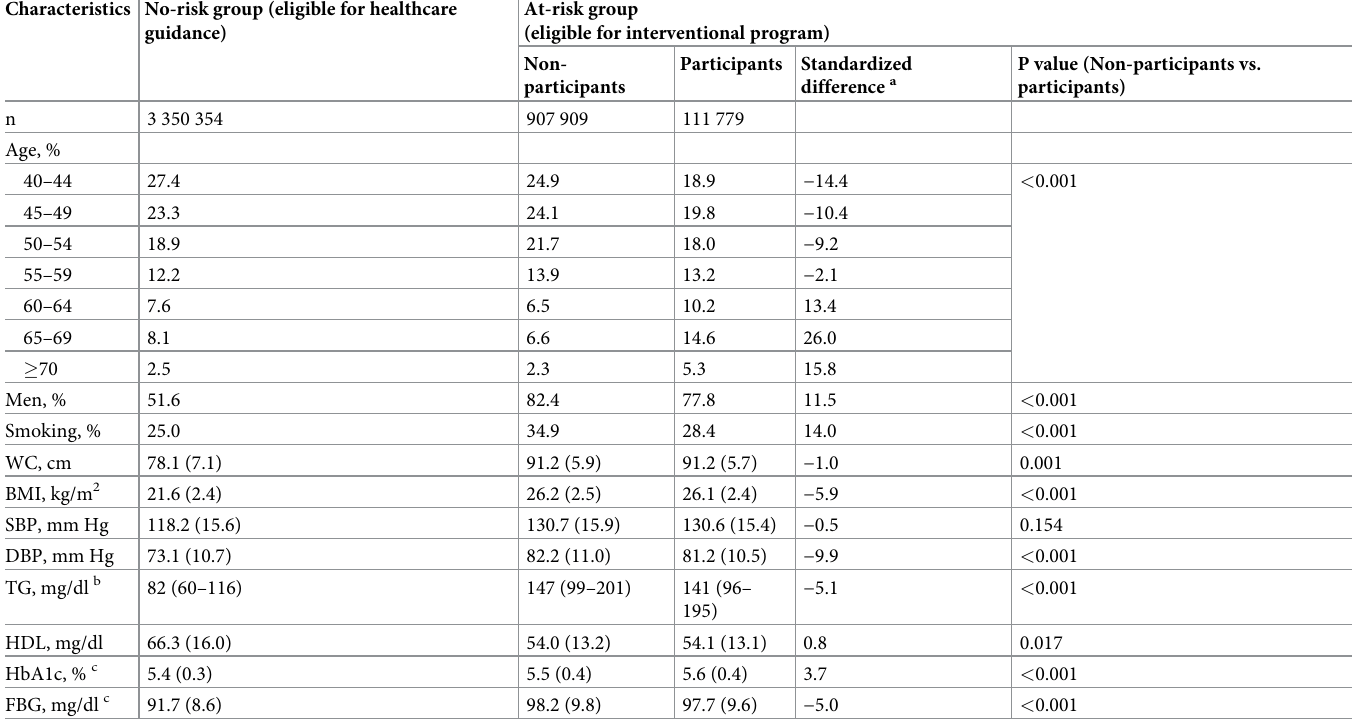
a Standardized difference is the mean difference divided by the pooled standard deviation, expressed as a percentage. b Standardized differences were calculated using log-transformed triglyceride. c FBG or HbA1c or both can be measured in the